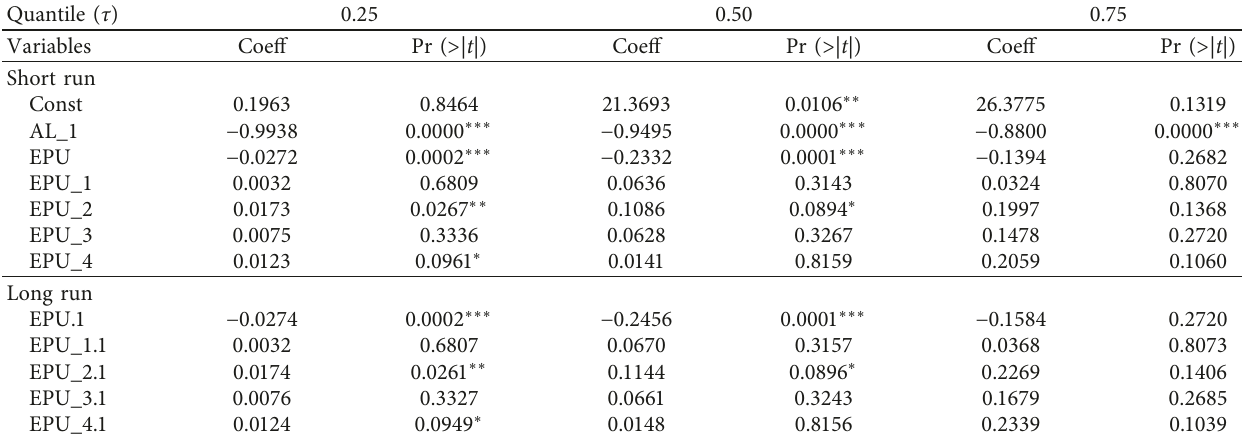
Table 4: QARDL estimation results: tranquil period (independent variable: